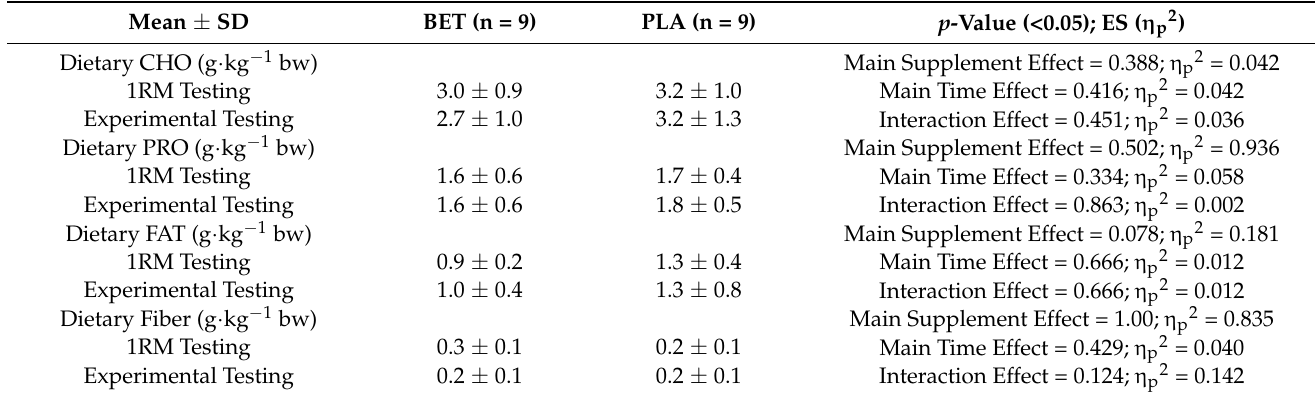
Table 3. Participant dietary macronutrient and fiber intake reported as average relative consumption (g · kg − 1 bodyweight) for the 24 and 48 h preceding both the second (1RM assessment) and third (experimental protocol) visit, respectively. All data are presented as means ± SD. In brief, there were no significant between-visit, supplement, nor interaction effects